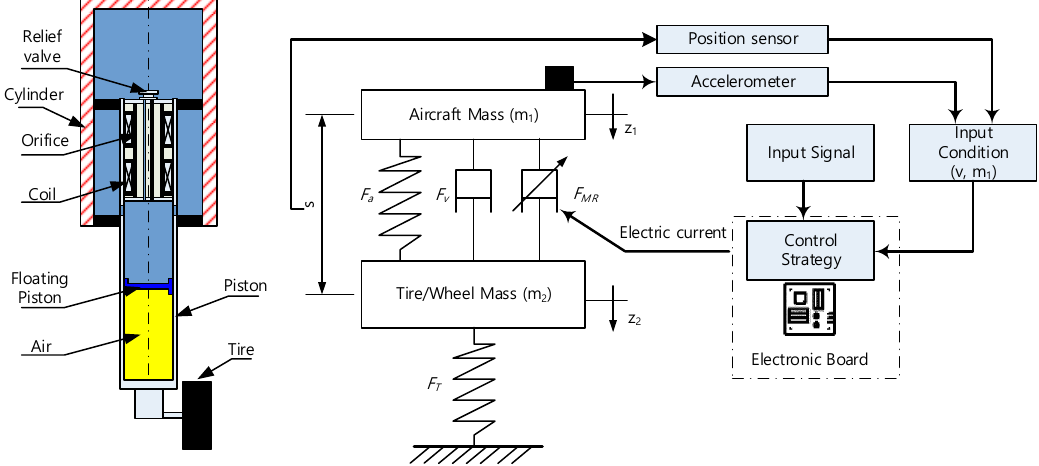
Figure 1. Landing gear system concept.